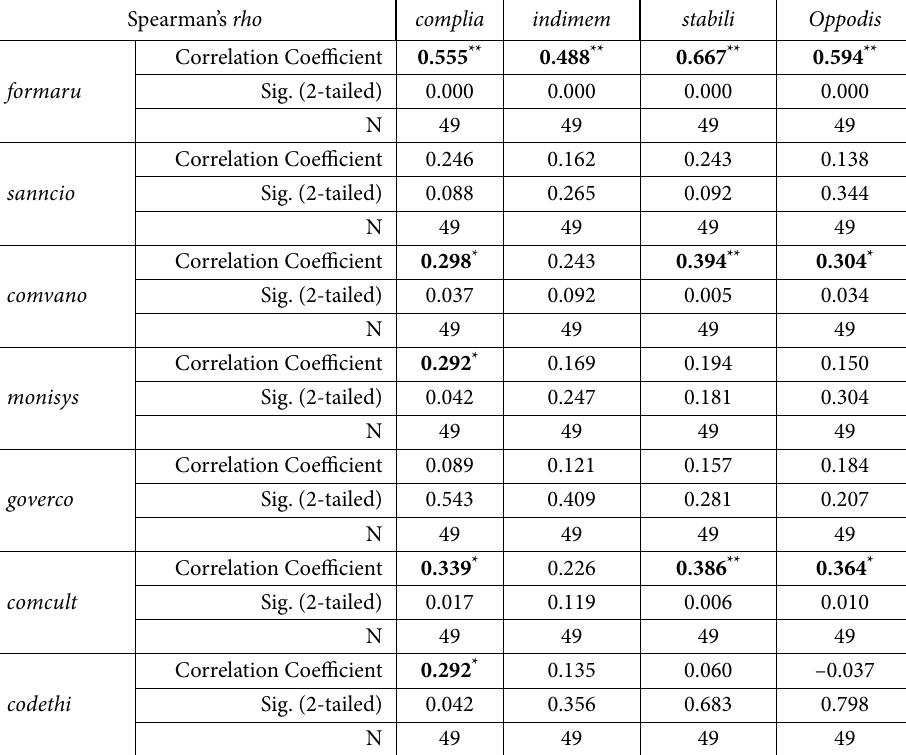
Table 8. Spearman’s rho correlation – H3 (source: authors’